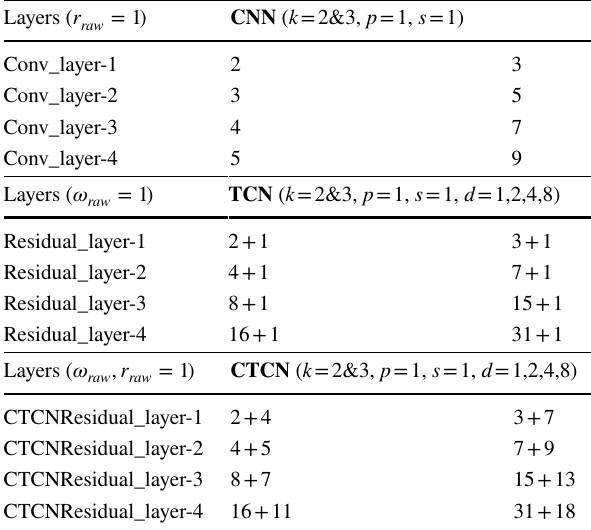
Table 17 Receptive field size of the CNN, the TCN, and the STRB = 1 Layers ( r raw )